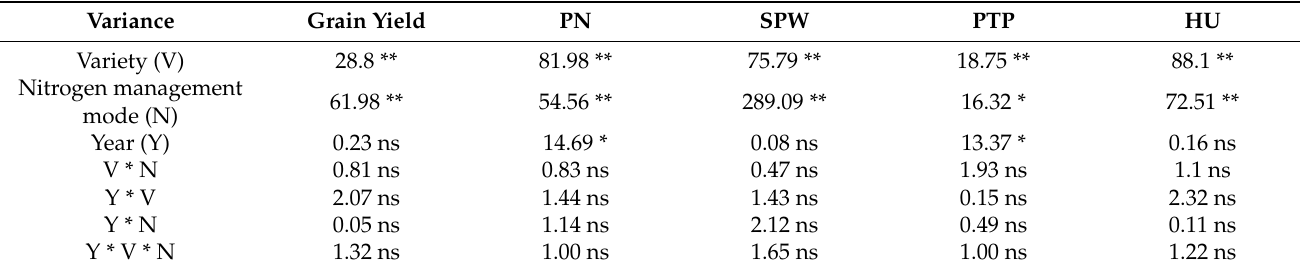
Figure 2. Dynamic changes in the rice heading uniformity over six days after the initial heading in the year 2017. N1, N2, N3, and N4 represent the ratios m (base and tillering fertilizer): m (panicle fertilizer) = 75:25, 60:40, 45:55, and 30:70, respectively; vertical bars represent means ± SEs. Four groups of letters from top to bottom in the same column indicate statistical significance at P = 0.05 among different nitrogen management regimens from large to small within the same time period. Table 4. Analysis of variance (ANOVA) of the effect of nitrogen management on grain yield components and heading traits at the heading stage in 2019 and